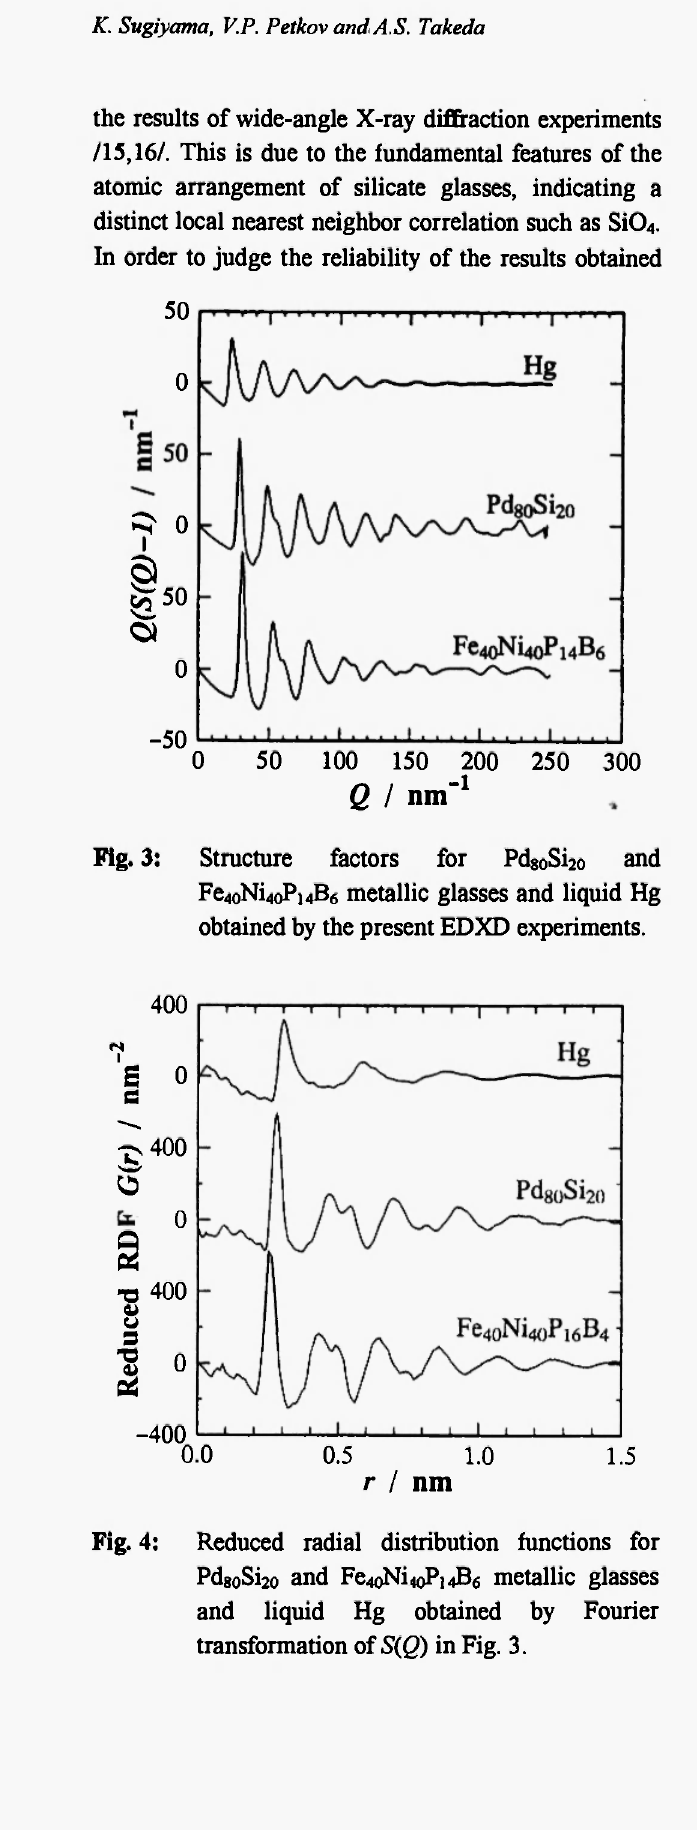
Fig. 4: Reduced radial distribution functions for Pd8oSi 2 o and Fe.wNiwPiÄ metallic glasses and liquid Hg obtained by Fourier transformation of S(Q) in Fig.